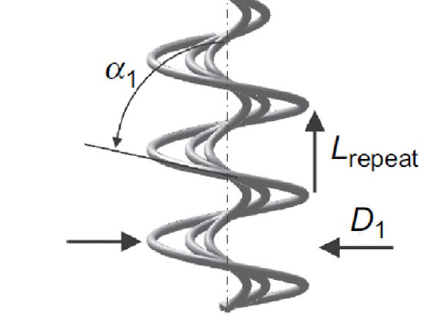
Figure 6. Single yarn